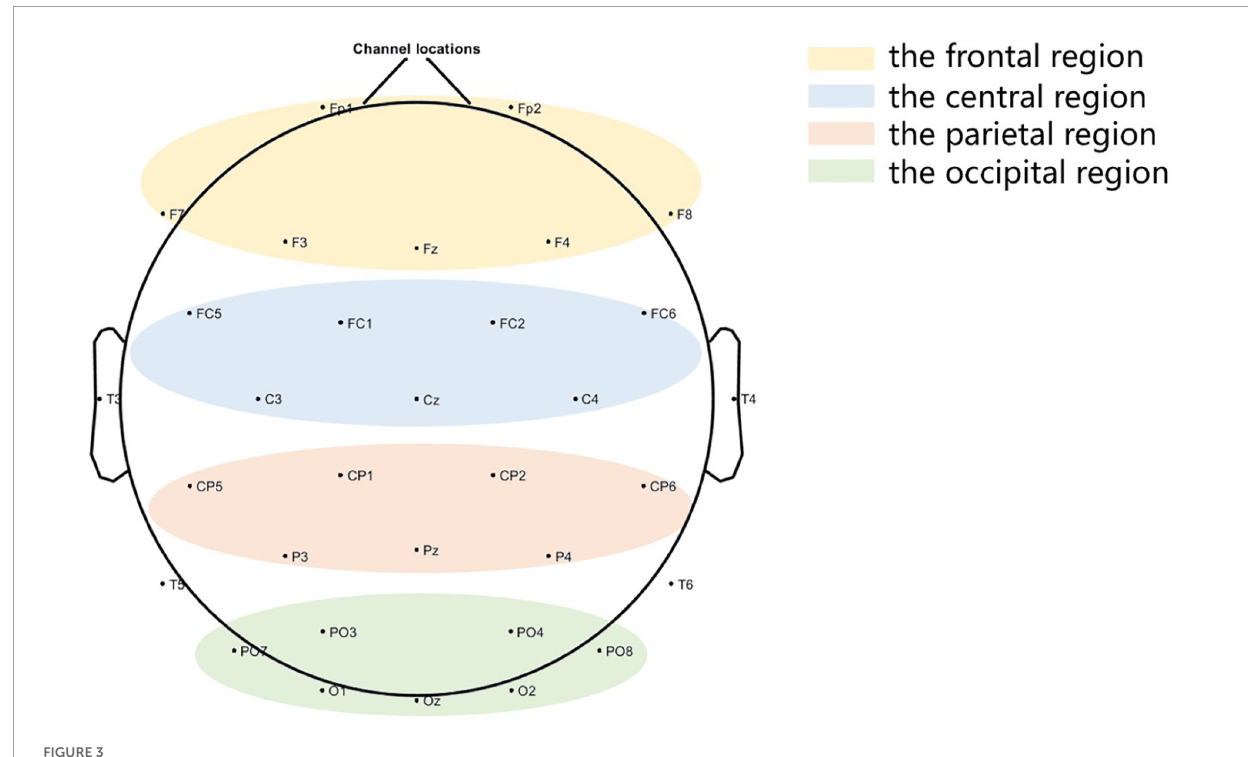
FIGURE3 Brain local